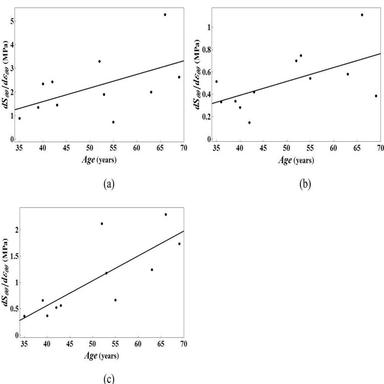
Correlation between stiffness, at 100 kPa stress, and donor's age for the three layers of the aorta in circumferential direction. (a) Circumferential intimal; (b) circumferential media; (c) circumferential adventitia.